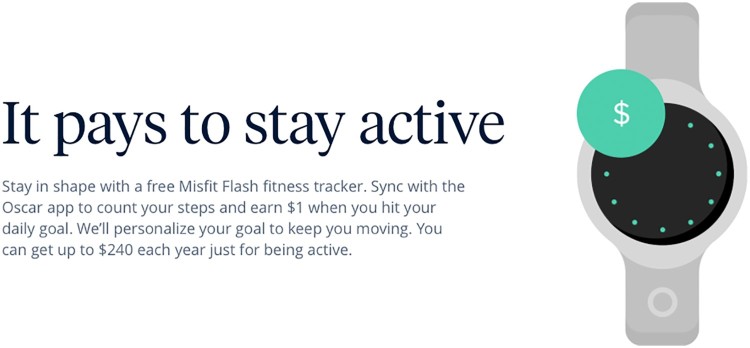
Oscar Health Misfit SchemeSource: Oscar Health screenshots, 17 April 2016.